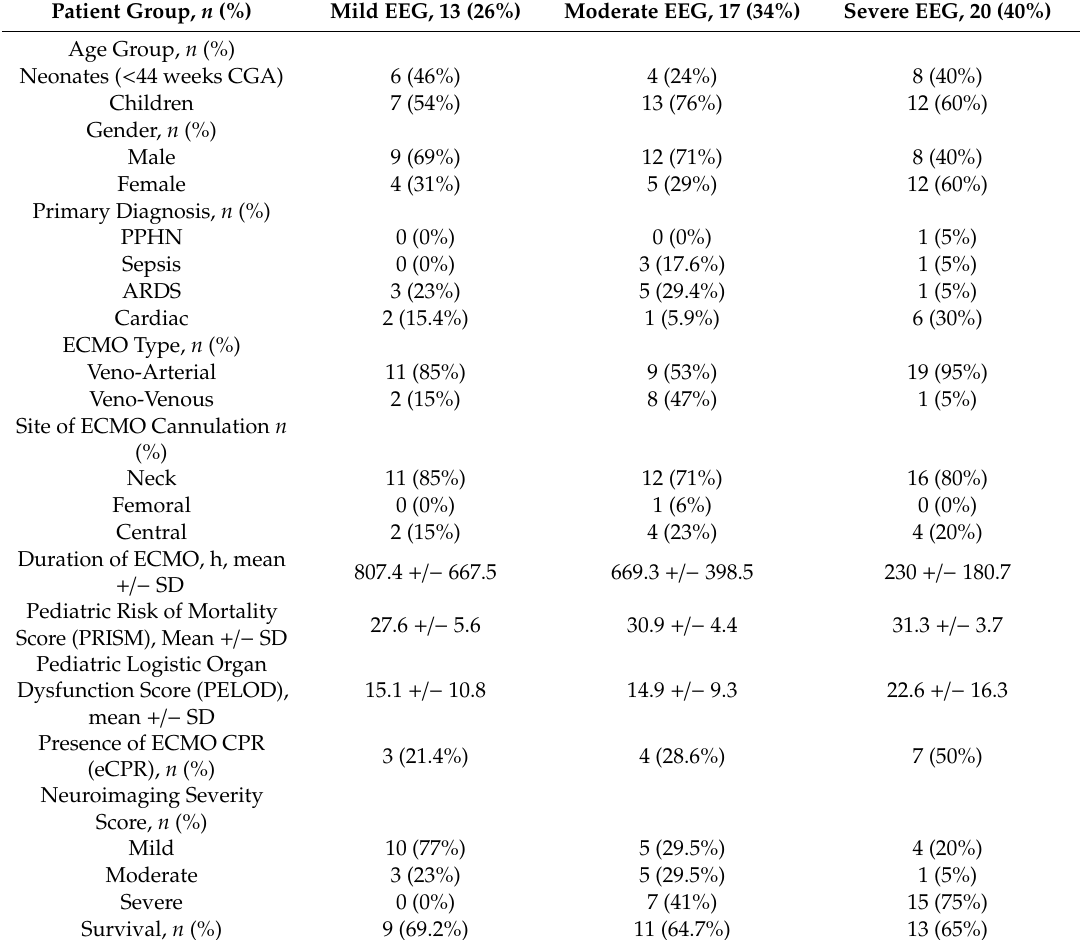
Table 3. Demographic characteristics of patients in the mild, moderate, and severe EEG